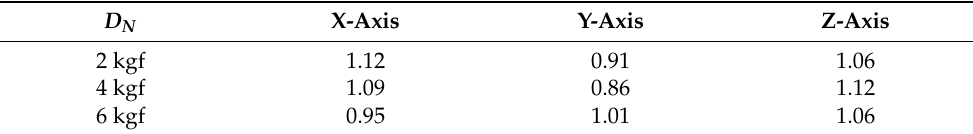
Table 10. DNF Number of axis X, Y, and Z from Sensor 2 of printing roll eccentricity fault.